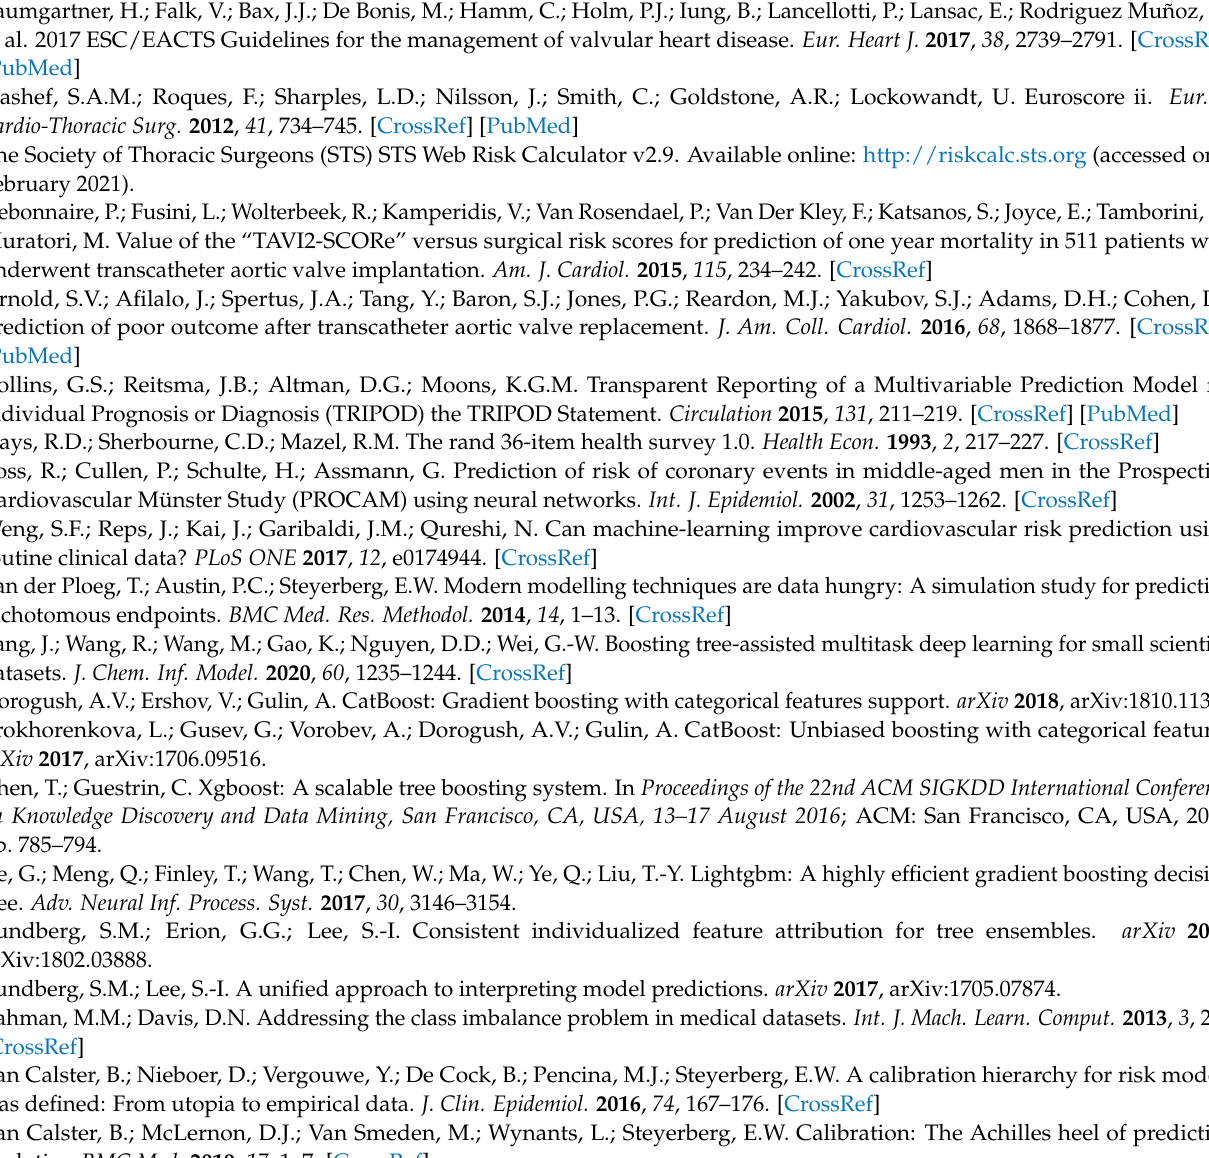
Figure A3. Survival and non ‐ survival rates per month.